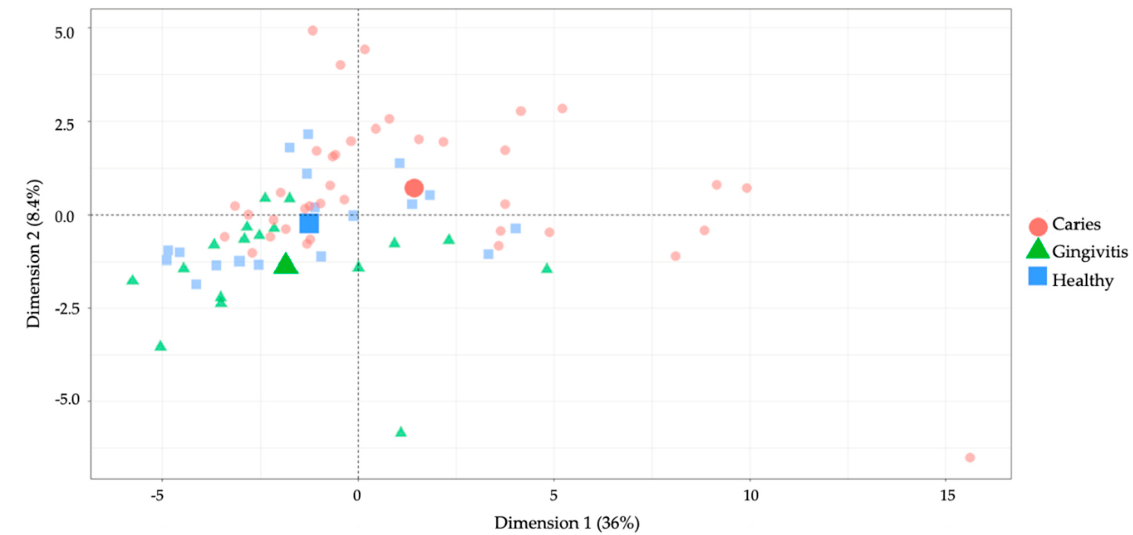
Figure 3. Results obtained from a principal component analysis (PCA) with the first dimension on the x-axis (36%) and the second dimension on the y-axis (8.4%). The groups are separated by color and shape (caries = red square; gingivitis = green triangle; caries = red circle). Three bigger shapes are located at the center of gravity for each group.